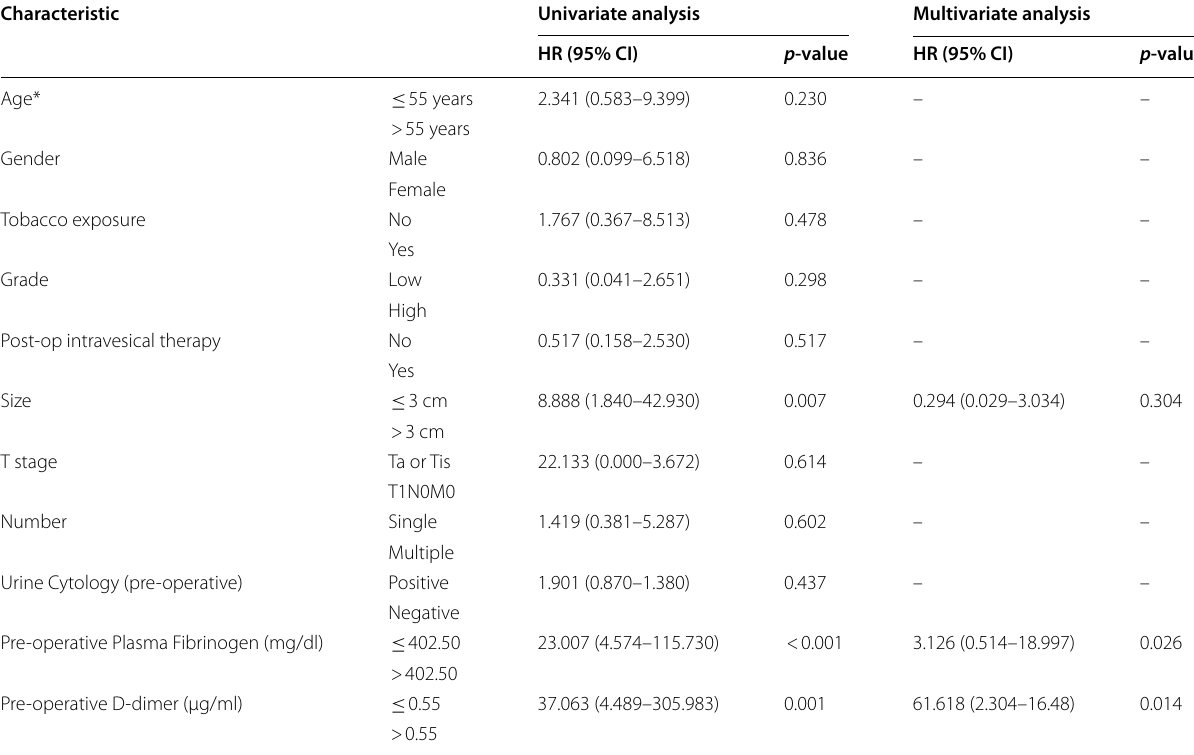
Table 3 Univariate and multivariate analyses of prognostic factors for disease recurrence by cox proportional hazards